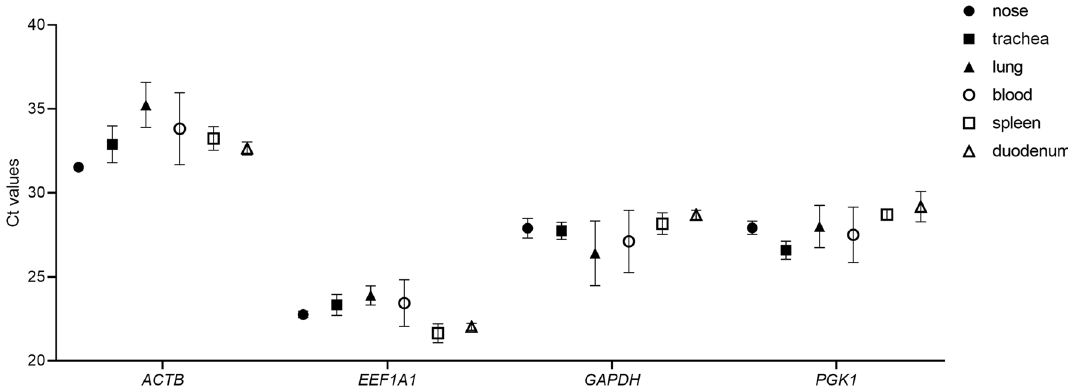
Figure 1. Ct values of selected reference genes in various tissues from Rousettus aegyptiacus . RNA was extracted from nose, trachea, lung, blood, spleen and duodenum from 12 animals. Expression of reference gene candidates were determined via qRT-PCR. Data show mean ± SD from 3 independent experiments.